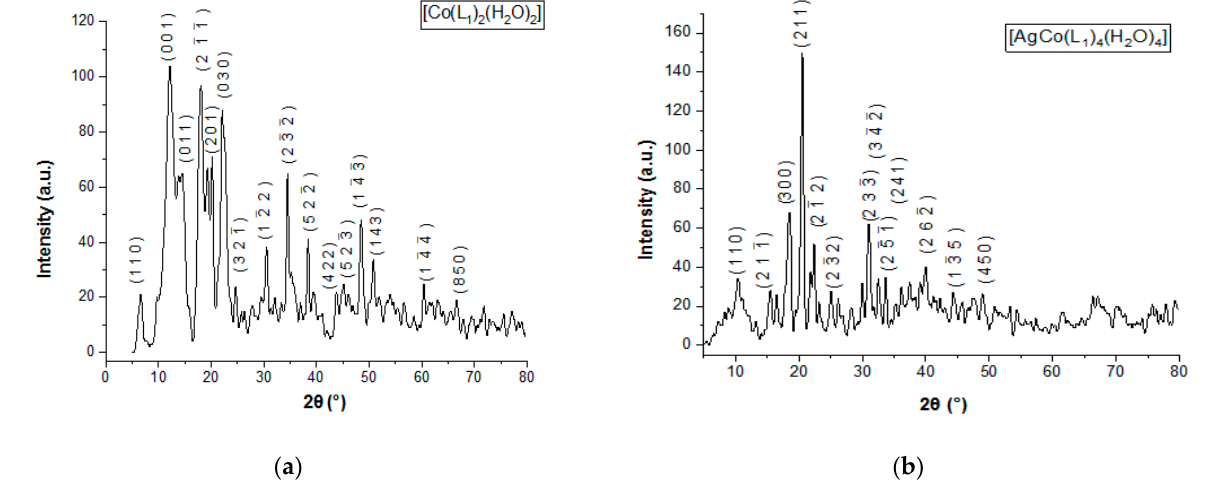
Figure 6. PXRD pattern: ( a ) PCC and ( b ) PCCAg 0 NPs. Table 5. Powder XRD parameters.